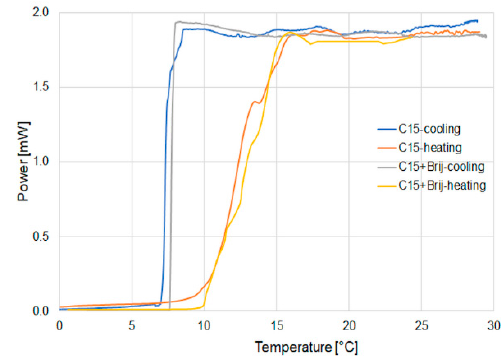
Figure 7. Hysteresis of power change for a pure material and with the Brij admixture for the example of C15 materials.